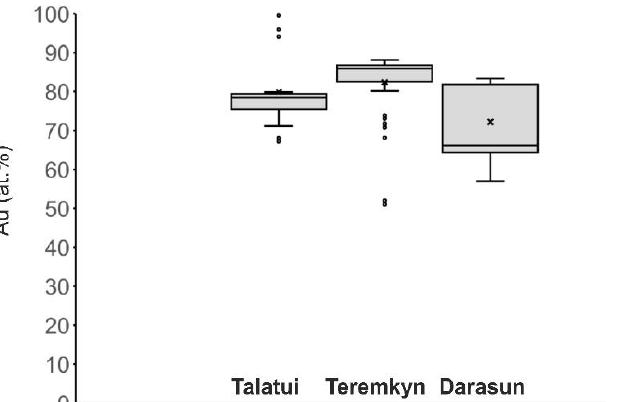
Figure 2. Concentrations of Au (at. %) in native gold in the gold ores at deposits of the Darasun goldfield (recalculated data from [18]). Here and in Figures 4 and 10–12, lines in the boxes are medians, crosses are averages, and spots are outliers (https://towardsdatascience.com/understanding-boxplots-5e2df7bcbd51).